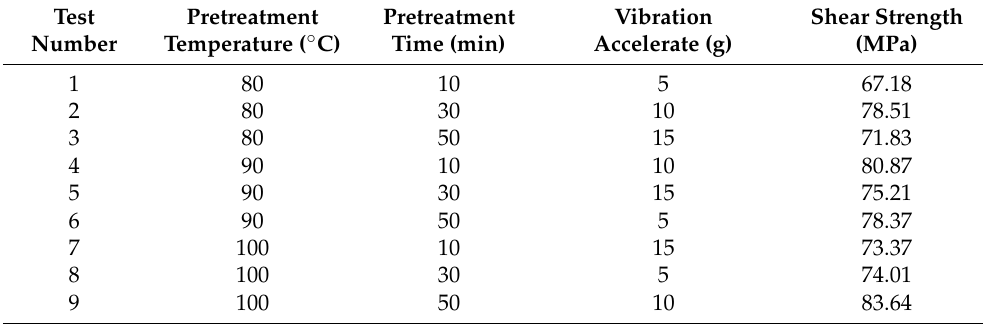
Table 2. Vibration pretreatment process orthogonal table and interlaminar shear strength results.